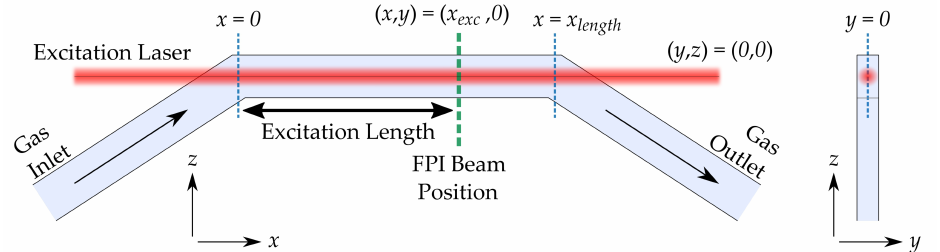
Figure 1. Schematic sketch of the channel geometry with the coordinates of the relevant elements in x – z -plane ( left ) and y – z -plane ( right ). The excitation laser beam (red) propagates centrally through the channel and collinear to the gas flow in the area of exposure, i.e., the excitation channel. Both gas duct (blue area) and etalon (positioned at the dashed green line) are rectangular with a size of 1 × 2 mm (width × height). The excitation length (black arrow) spans approximately 10 mm, starting at the transition from the curvature to the horizontal part of the channel and ending at the position of the FPI probe laser